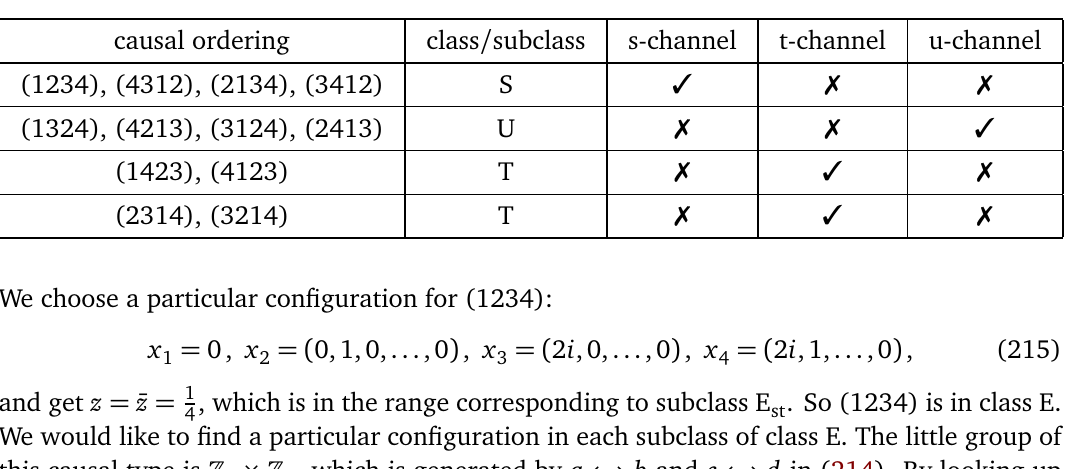
Table 13: OPE convergence properties of type 9 causal